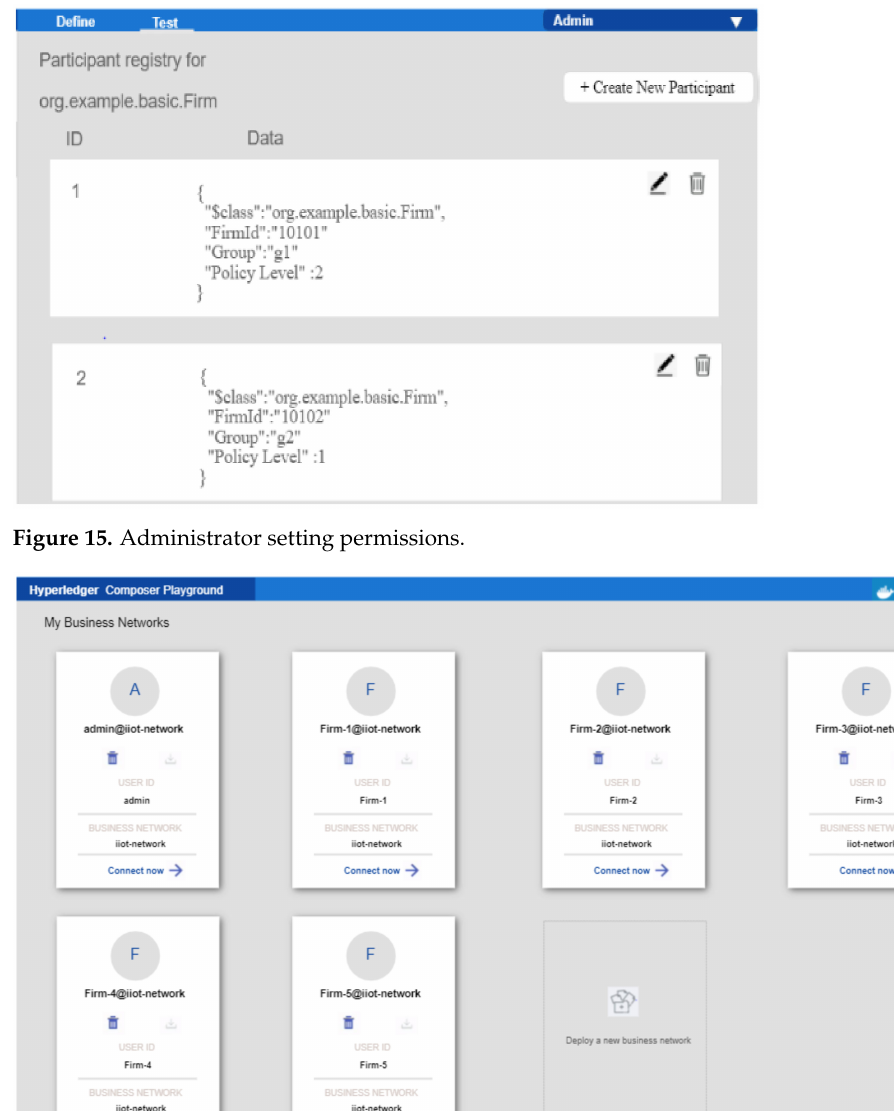
Figure 17. Check Access